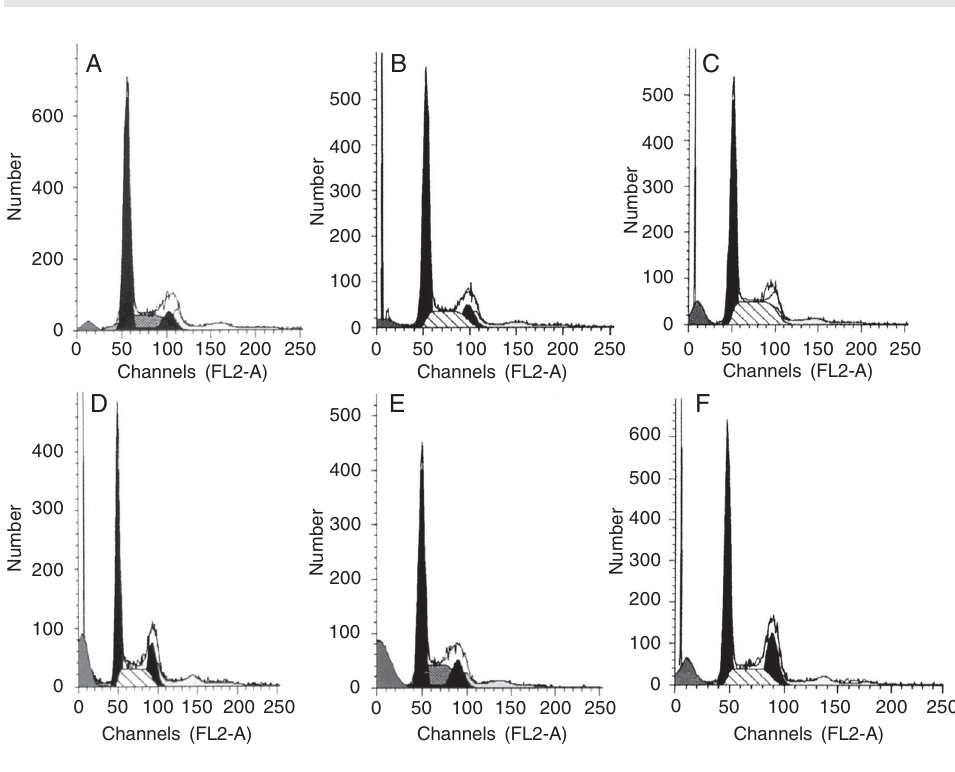
Figure 4. Flow cytometric analy- sis of DNA content of HL-60 cells treated with various doses of fraction FA-2-b-ß for 96 h. A , Medium alone, G1: 66.3%, G2/